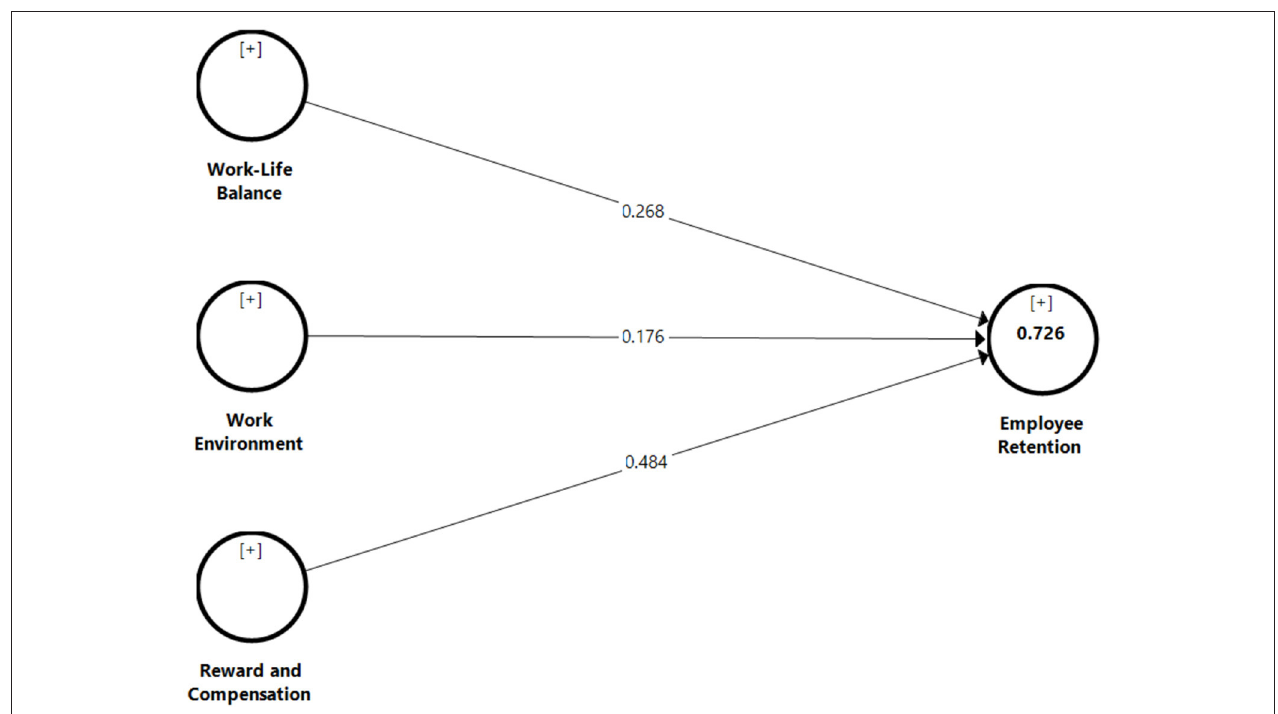
FIGURE 1 | Results of assessment of structural